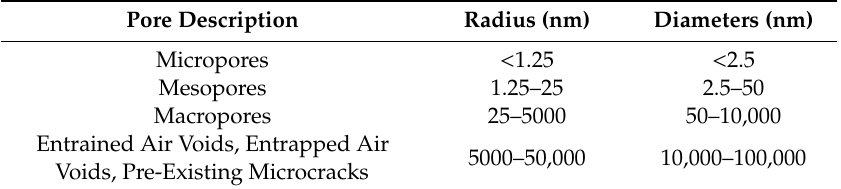
Table 7. International Union of Pure and Applied Chemistry (IUPAC) pore size